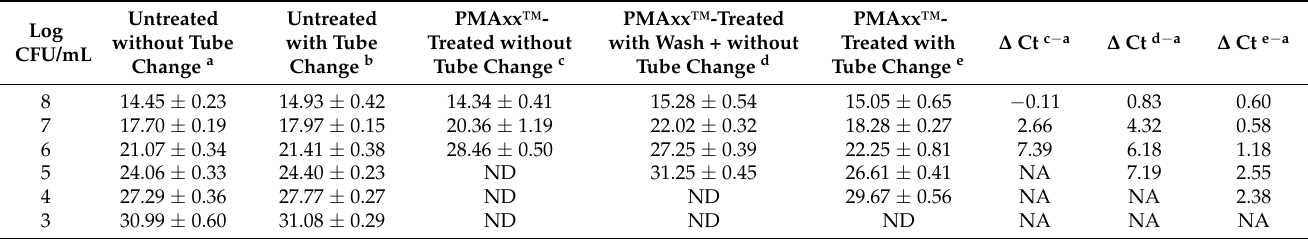
Table 3. Average Ct values for the effect of post-PMAxx™ treatments * under different conditions on live